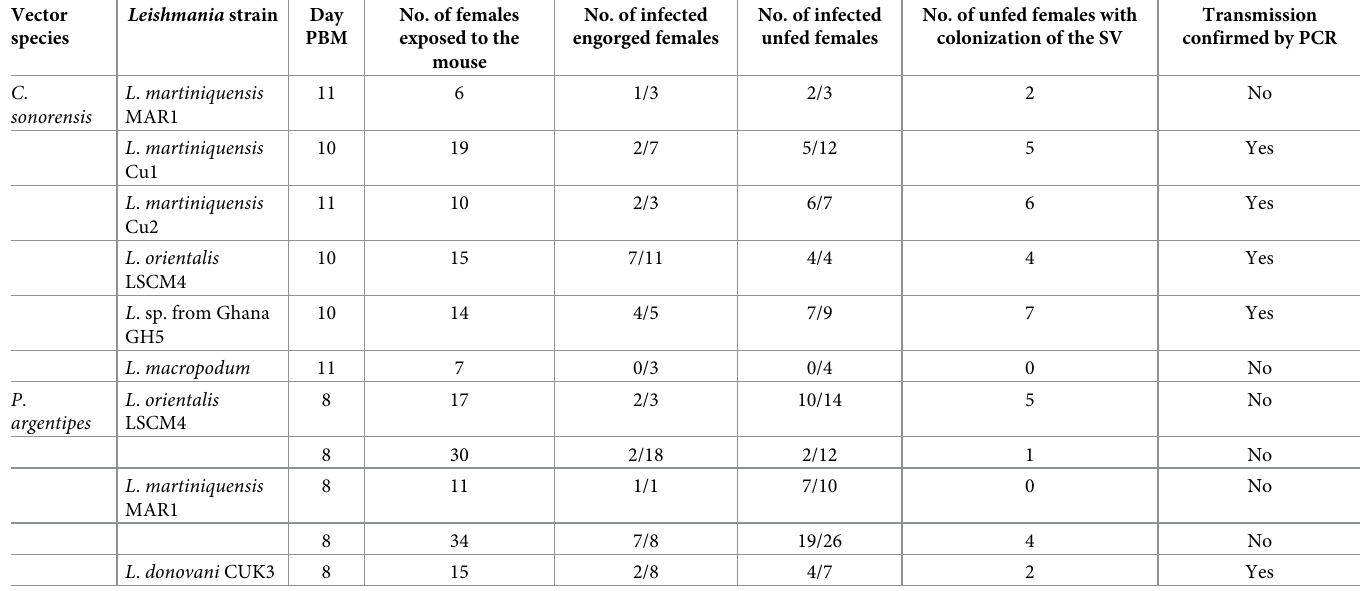
Table 3. Microscopical examination of C . sonorensis and P . argentipes females exposed to BALB/c mice for transmission of parasites and result of PCR detection of Leishmania minicircle kDNA in mouse